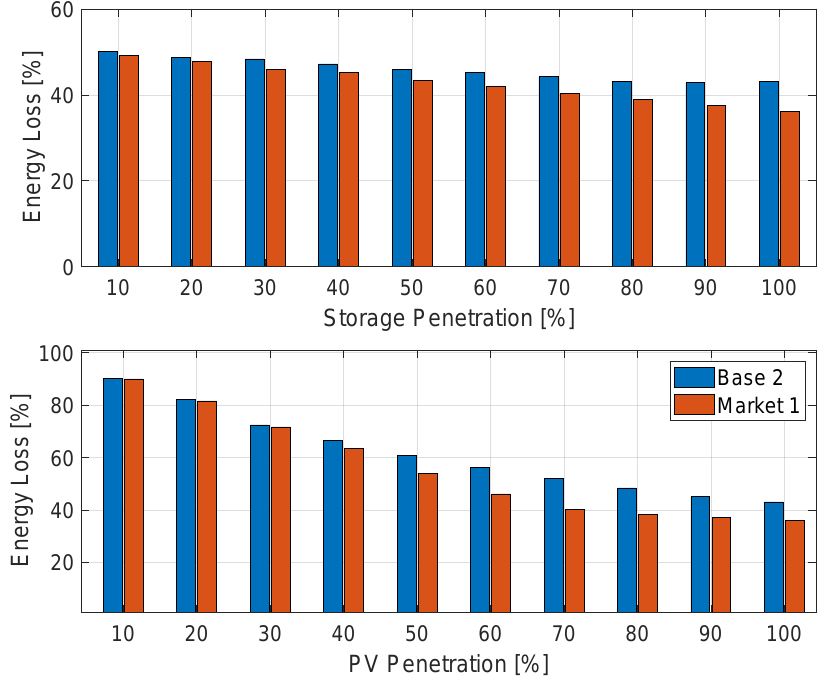
Figure 13. Load loss as a percent from the no-DER deployment scenario for different PV